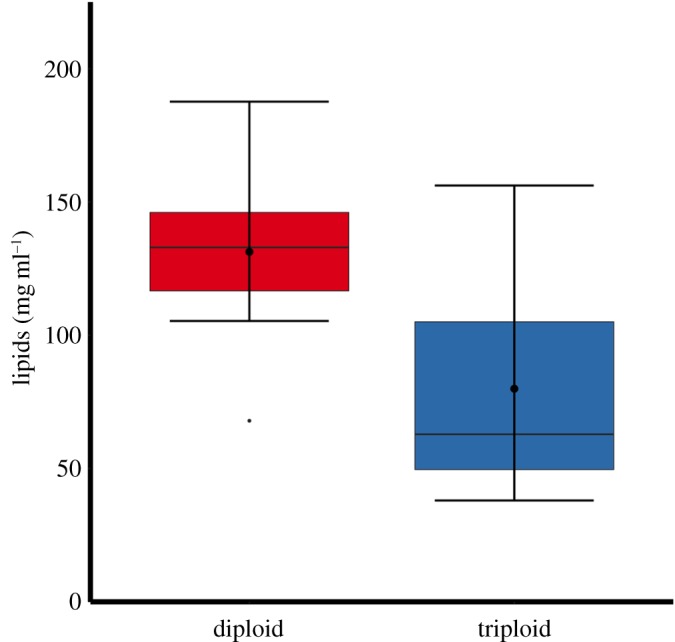
Boxplot showing muscle tissue total lipid content is higher in 2-year-old diploid (n = 15) than in triploid (n = 15) Atlantic salmon. Boxplots show median (horizontal black line) and mean (thick black dot); whiskers indicate points within the 1.5 IQR and quartile ranges (coloured box area).